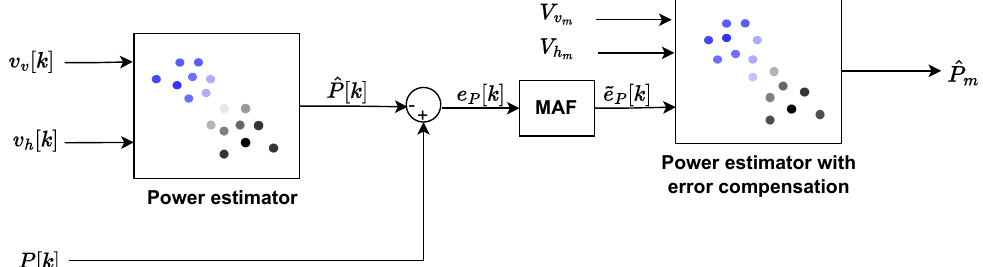
Figure 3. Proposed system for the estimation of the required power during a flight. It is composed of two cascaded subsystems based on fuzzy clustering. The first subsystem must determine the required power for the current system velocity, and the second subsystem determines the required power for subsequent mission stages based on the expected velocities and the determined power- estimation